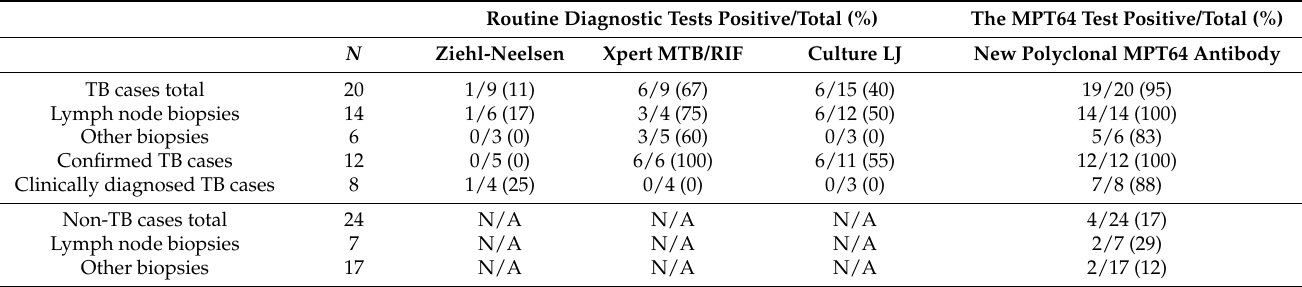
Table 3. Results of routine diagnostic tests and the MPT64 test performed on clinical TB and non-TB samples. Routine Diagnostic Tests Positive/Total